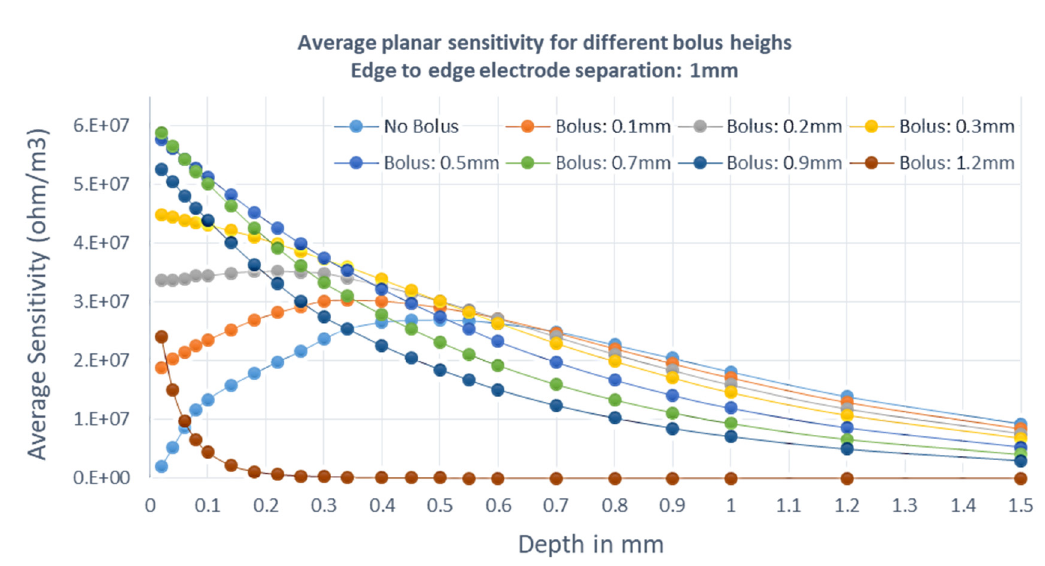
Fig.6: Variation of plane average sensitivity along depth with different conducting layer (bolus) height for edge to edge electrode separation of 1mm. Depth zero indicates the surface of the volume conductor with or without the interposing conducting layer (probe).